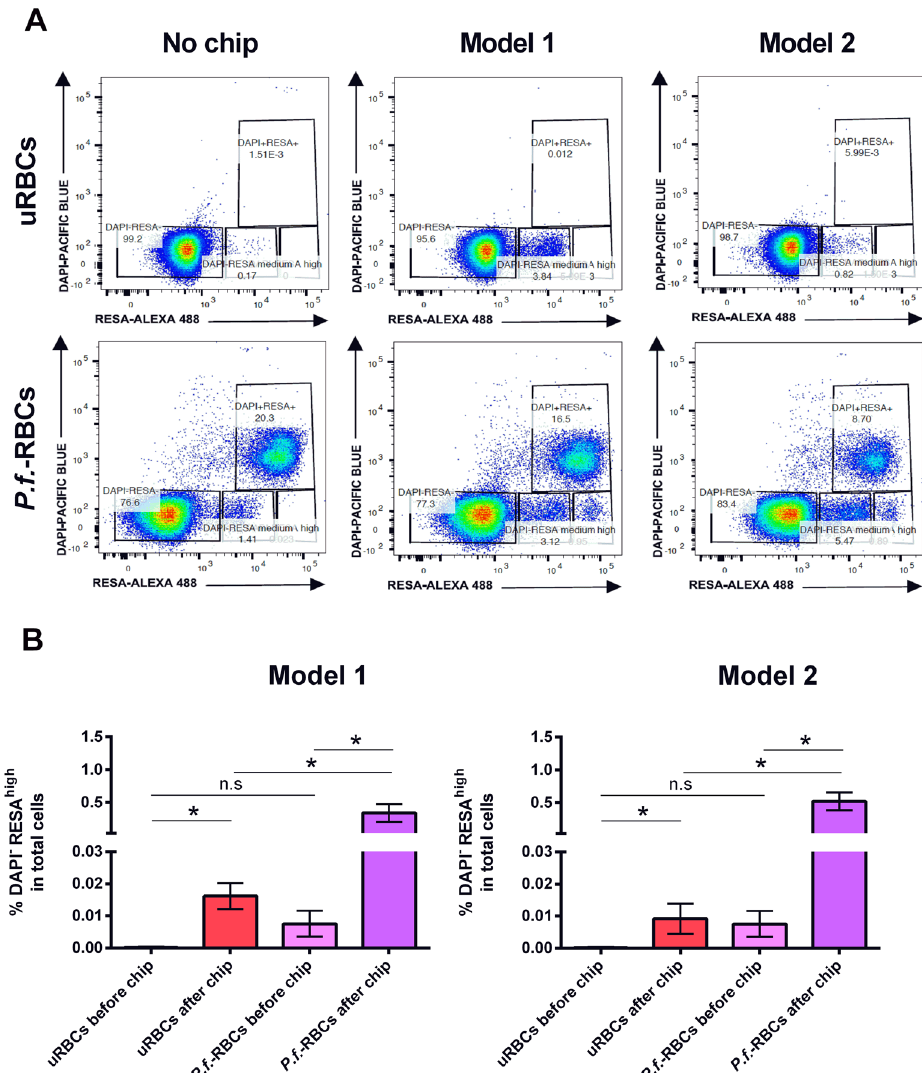
Figure 6. Flow cytometry-based pitting quantification. uRBCs and P.f.- RBCs were collected and analyzed by flow cytometry before and after passing through the microfluidic devices. Cells were gated according to the strategy described in Supplementary Fig. S3. ( A ) Representative dot plots of uRBCs (DAPI - RESA - ), autofluorescent uRBC (DAPI - RESA medium ), P.f.- RBCs (DAPI + RESA + ), O-iRBCs (DAPI - RESA high ) before (No chip) and after passing through microfluidic device models 1 and 2. This figure corresponds to one experiment out of seven. Twelve devices were used in each experiment (six of model 1 and six of model 2). ( B ) Frequencies of DAPI - RESA high cells from model 1 and model 2 between uninfected and infected cells before and after passing through the devices were compared. Data represent the mean and standard error of the mean obtained from seven independent experiments. Statistical significance was assessed by a t test with Wilcoxon signed-rank post- test, being considered statistical significance (* p value <